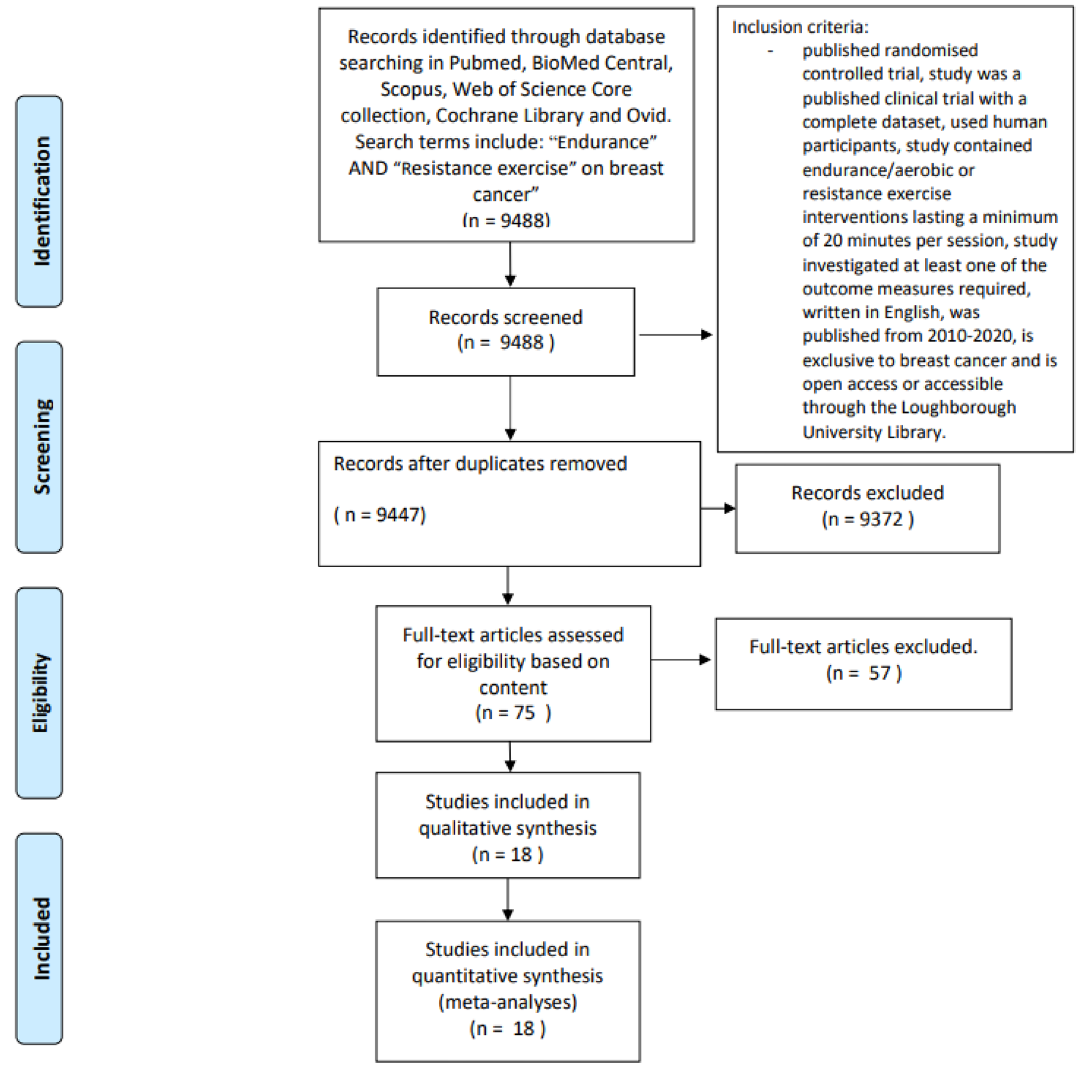
Figure 2. PRISMA 2009 flow diagram detailing the step-wise process used for study selection for these meta-